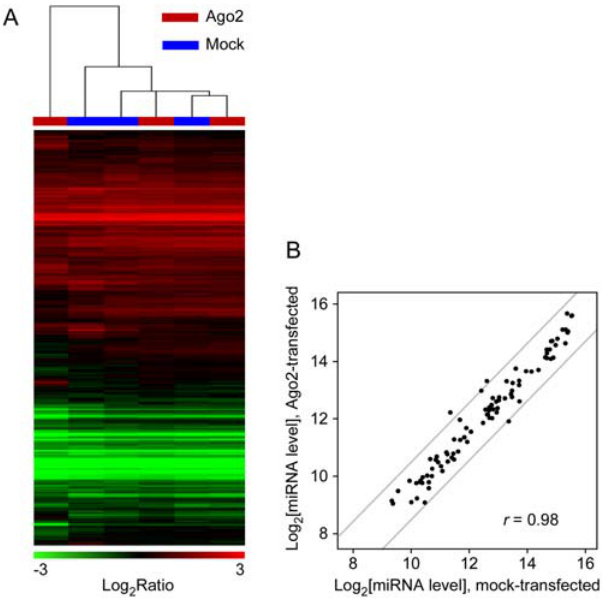
Figure 2. Overexpression of FLAG-Ago2 does not perturb overall mRNA expression or miRNA expression. (A) Unsupervised hierarchical cluster of mRNA levels in HEK293T cells determined relative to a universal reference for RNA from FLAG-Ago2 transfected cells (red) and mock transfected cells (blue). Rows correspond to 12,931 gene elements (representing , 9,059 genes) and columns represent individ- ual experimental samples ( r ave =0.92, Pearson correlation between averaged values from each side of the highest node in the dendrogram). (B) Scatter plot of the normalized log 2 microarray signal intensity of 90 expressed miRNAs from whole cell lysates of mock transfected cells (x-axis) versus the normalized log2 microarray signal intensity from Ago2 transfected cells (y-axis, r =0.98). Values are the averages of 3 experiments. The grey lines delineate the boundary for a two-fold